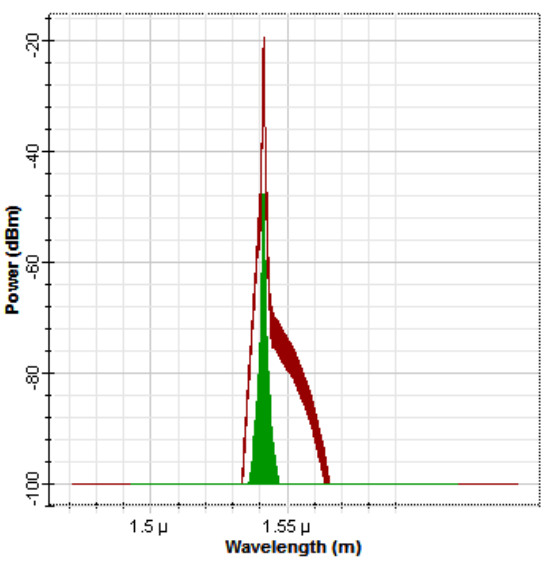
Figure 6. Output spectrum for BPF2.